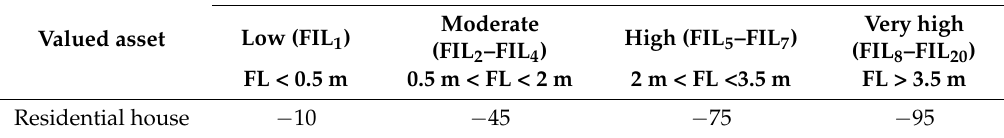
Table 4. Custom response function (RF) used to approximate fire effects in terms of value loss (%)